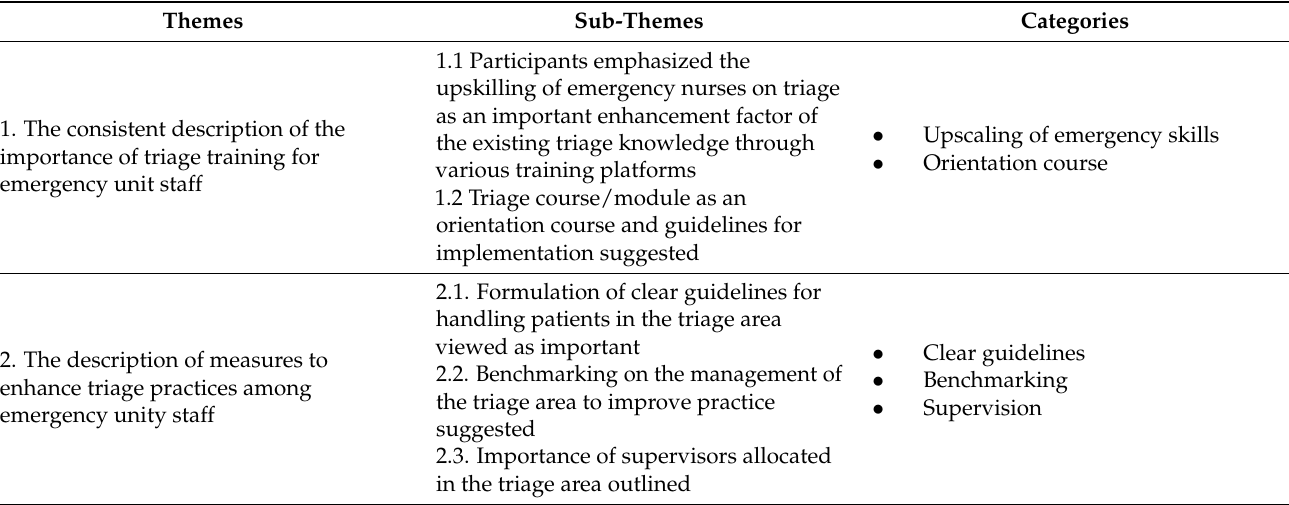
Table 3. Summary of the main findings according to themes and sub-themes and